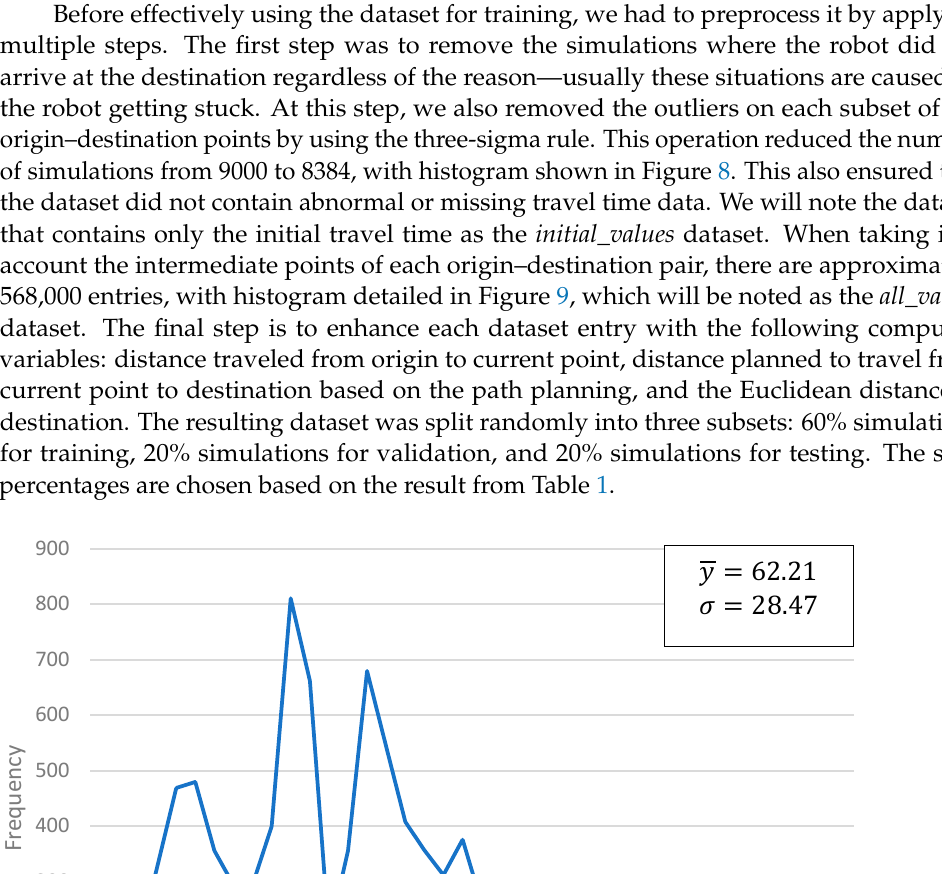
Figure 9. Histogram for all_values dataset, mean and standard deviation. Table 1. Dataset split percentage. 60-20-20